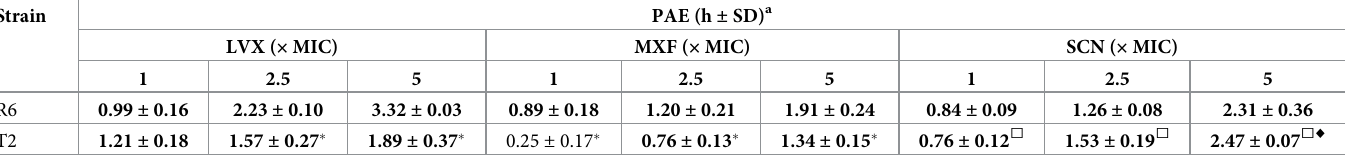
Table 3. PAE in sessile S . pneumoniae strains forming biofilms after 1 h exposure to drug, measured by viable count method. Strain PAE (h ± SD) a LVX ( × MIC) MXF ( × MIC) SCN ( × MIC) 1 2.5 0.99 ± 0.16